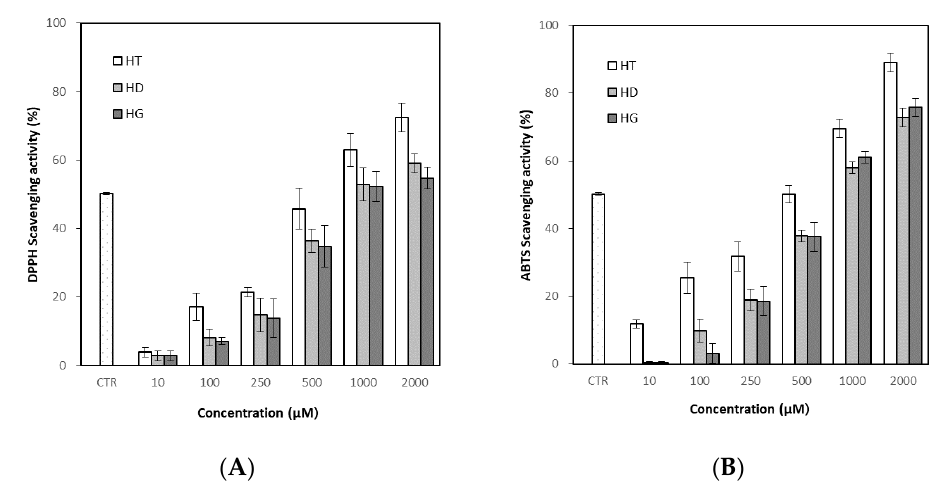
Figure 5. Antioxidant activity of hesperetin, hesperidin and hesperidin glucoside. Results were expressed as a mean ± SD ( n = 3). ( A ) 1,1-diphenyl-2-picrylhydrazyl (DPPH) radical scavenging activity, ( B ) 2,2′-azino-bis-3-ethylbenzthiazoline-6-sulphonic acid (ABTS) radical scavenging activity. CTR+; positive control (ascorbic acid), HT; hesperetin, HD; hesperidin, HG; hesperidin glucoside.